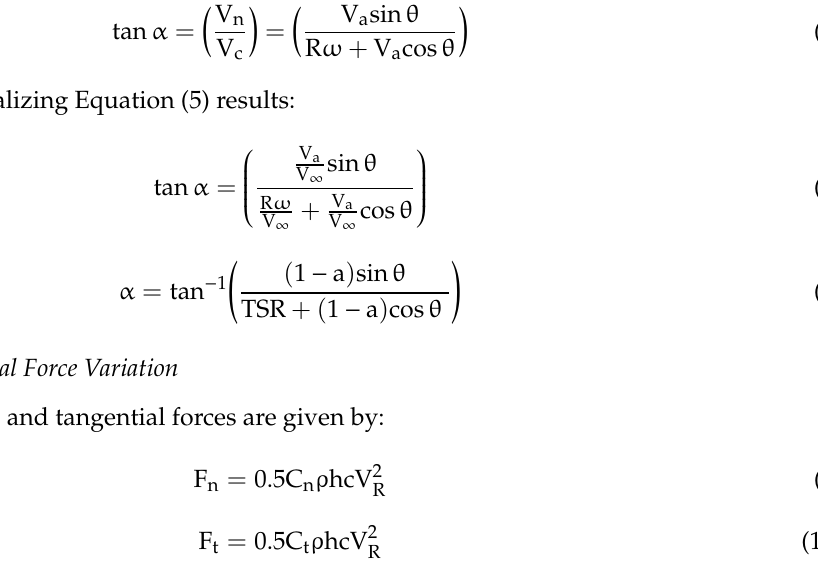
Figure 5. Force diagram of a blade airfoil.